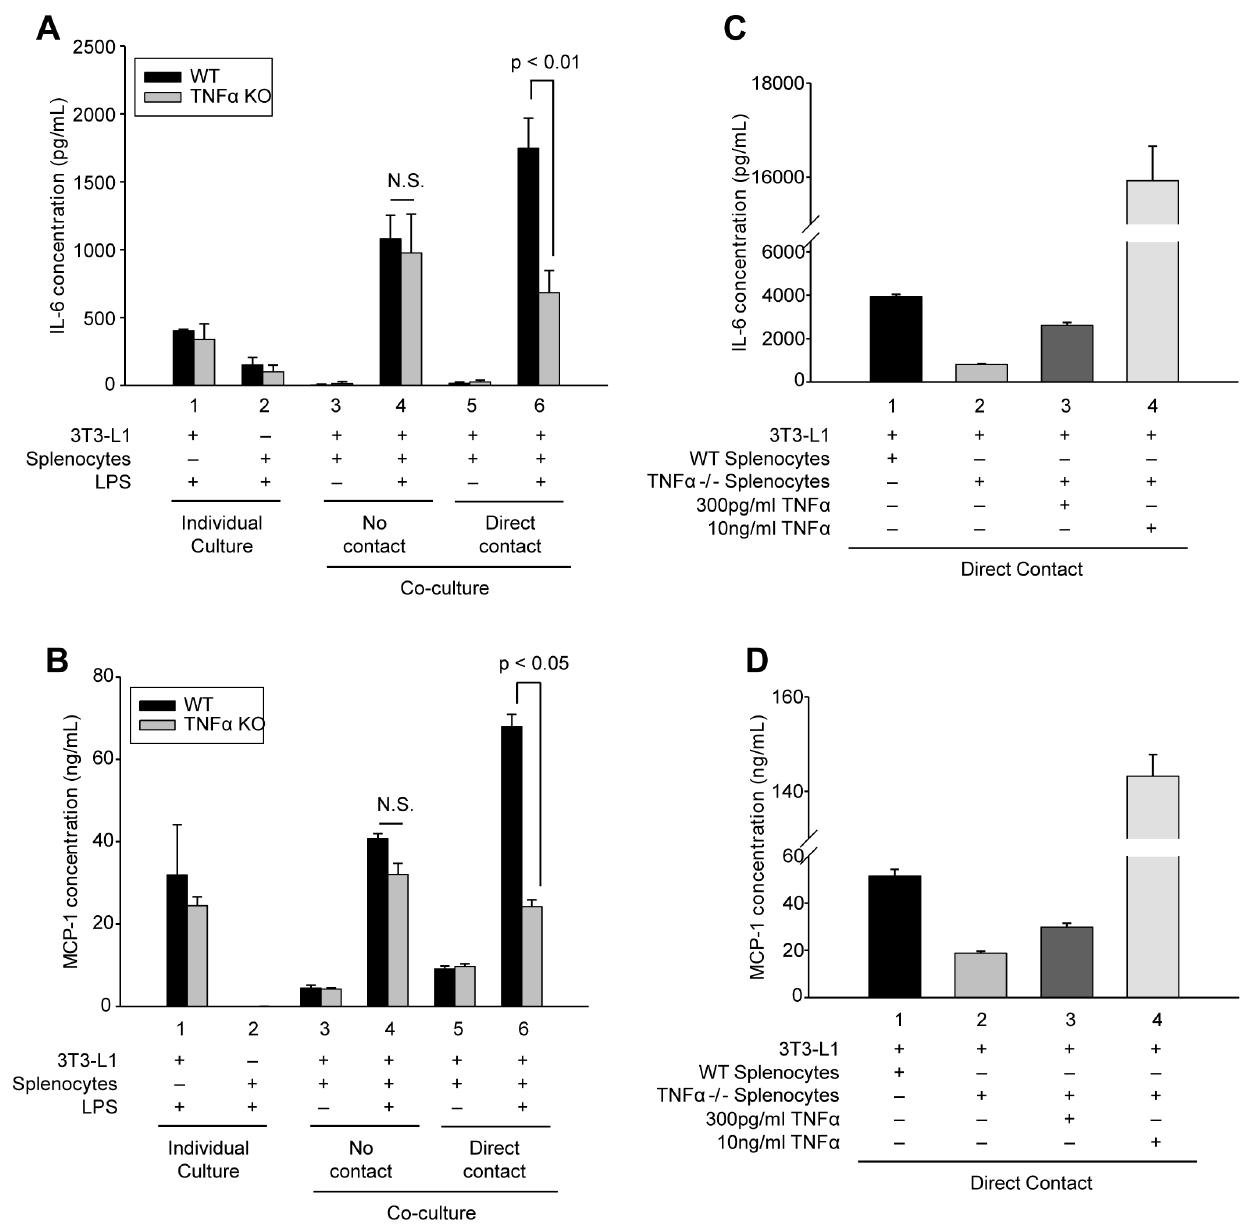
Figure 4. Cell contact-mediated enhancement of IL-6 and MCP-1 secretion requires TNF a signaling. (A and B) Differentiated adipocytes or murine splenocytes (black bars, isolated from wild type mice; gray bars, isolated from TNF a -/- mice) were cultured alone (individual culture, columns 1 and 2) or in co-culture with no contact (columns 3 and 4) or direct contact (columns 5 and 6) as in Figure 1. Cells were incubated in the absence ( 2 ) or presence ( + ) of LPS (1 m g/mL) for 24 h as indicated. (C and D) Wild type (WT) or TNF a -/- (TNF a KO) splenocytes were incubated with adipocytes with direct contact in the presence of LPS (1 m g/mL) and co-cultures were supplemented with 0, 300 pg/mL or 10 ng/mL purified murine TNF a as indicated. Secreted IL-6 (A and C) and MCP-1 (B and D) were quantified by capture ELISA. Experimental points were measured in triplicate (A and B) or duplicate (C and D) for calculation of means and standard deviations. For (A and B) comparison between individual cultures, co-cultures with no contact and co-cultures with direct cell-cell contact from WT and TNF a KO were calculated using ANOVA and followed by the post-hoc Bonferroni test. For C and D all experimental points were compared statistically by ANOVA followed by the Bonferroni post-hoc test, and differed significantly (p , 0.01). N.S. denotes no statistical difference. contact. For this measurement, GFP-expressing splenocytes were once again used for co-culturing with adipocytes to permit FACS separation of the two cell types prior to RNA isolation. By qRT- PCR analyses, we found that direct contact of LPS-activated splenocytes and adipocytes reduced IL-10 splenocyte mRNA expression by 50% (Fig. 5B).